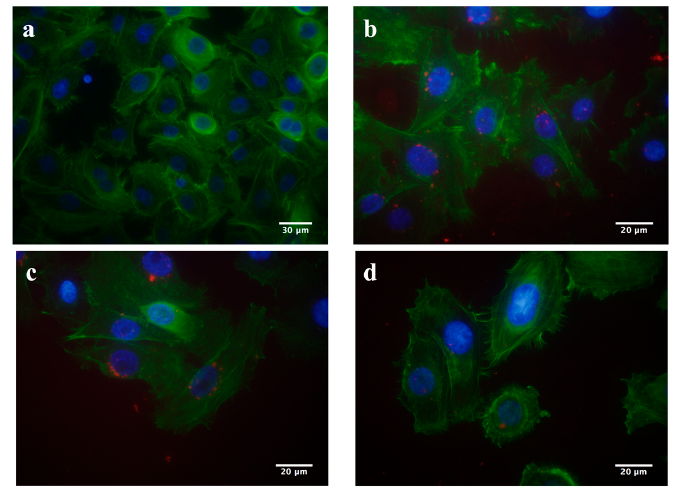
Figure 2. Fluorescent images of the hGECs incubated with the RITC ‐ NPs for 0 h as the control ( a ) and 24 h ( b ). The cells were further incubated in the nanoparticle ‐ free medium for another 24 h ( c ) and 48 h ( d ). The cell nuclei and cytoskeletal F ‐ actin fibers were fluorescently stained with blue and green, respectively. The red fluorescence represents RITC ‐ NPs.